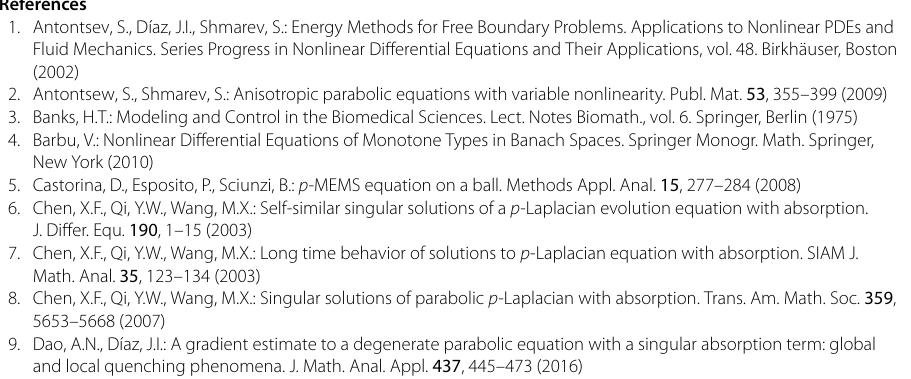
Figure 16 p = 4, α =